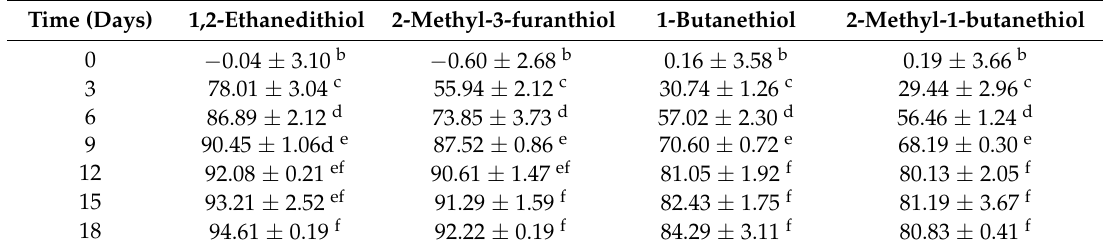
Table 1. Effect of storage at room temperature on acrylamide disappearance a